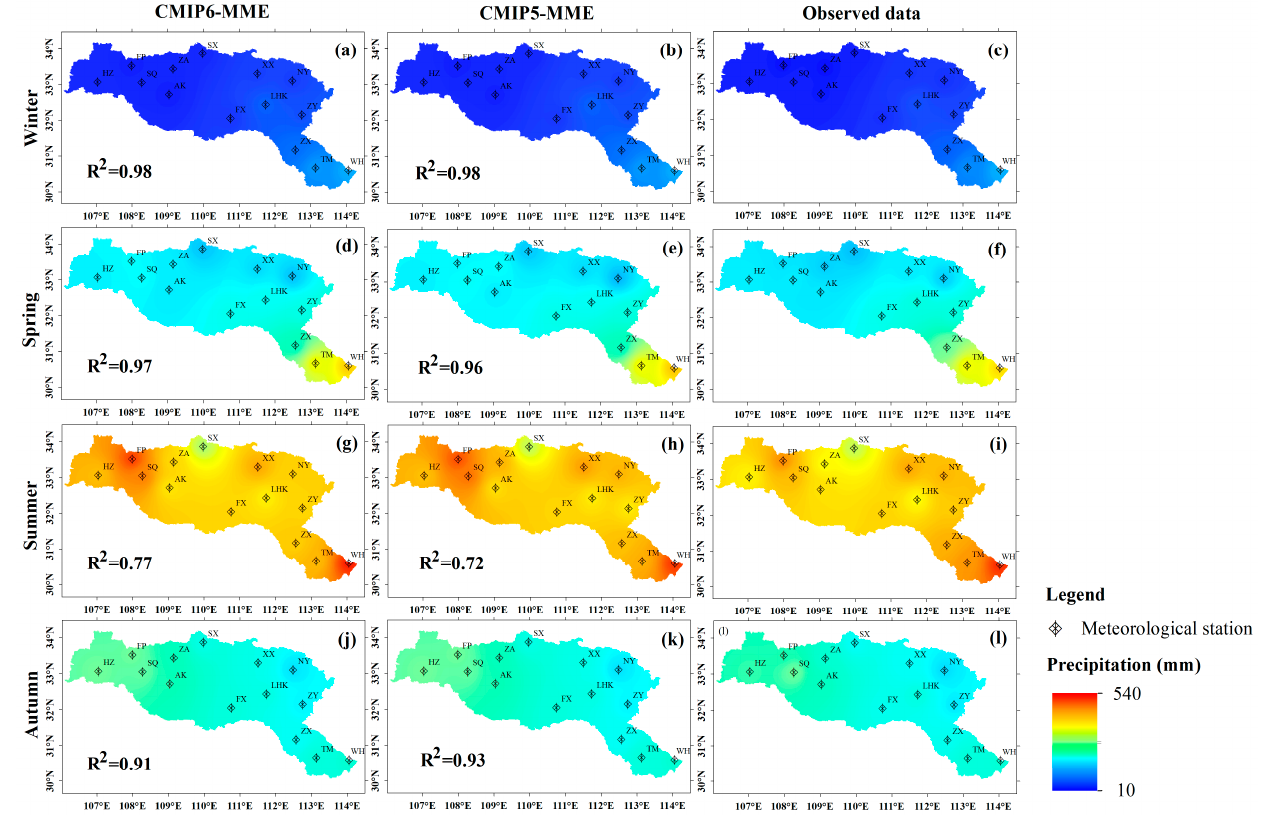
Figure 10. Precipitation (mm) of the CMIP6-MME downscaled data, the CMIP5-MME downscaled data, and the observed data in winter ( a – c ), spring ( d – f ), summer ( g – i ), and autumn ( j – l ) from 1970 to 2005. Determination coefficients ( R 2 ) are between observed data and the GCMs’ downscaled data.